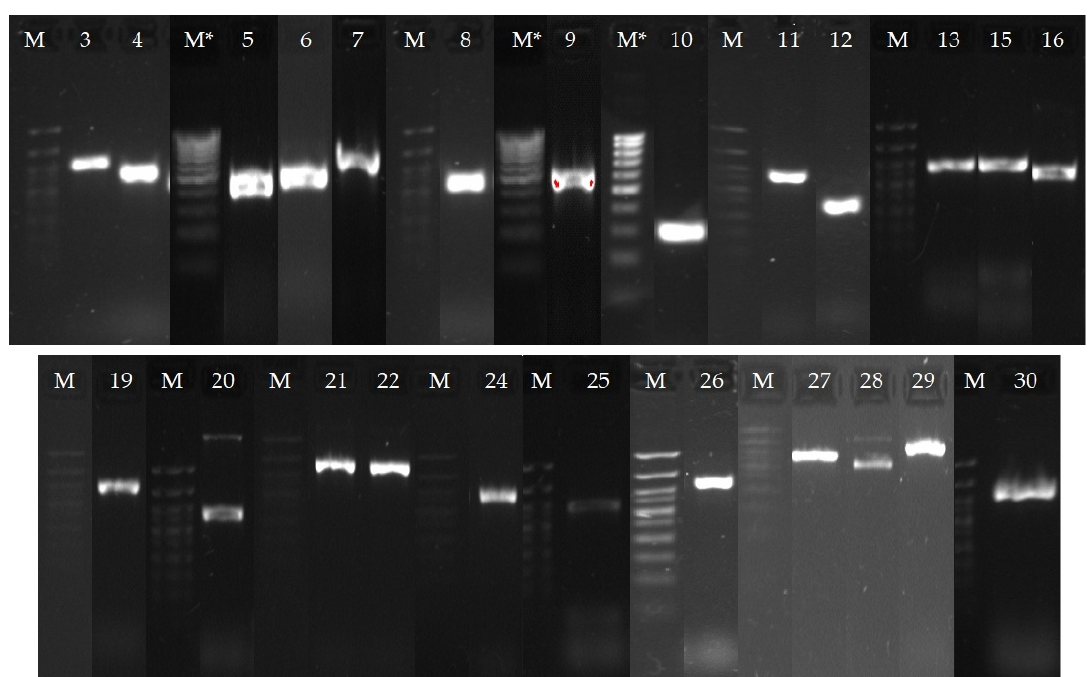
Figure 10. Gel electrophoresis of real-time PCR products with specific primers for genes encoding CYP450: M is a marker of DNA lengths from 700 to 50 bp (bands from top to bottom: 700, 500, 400,